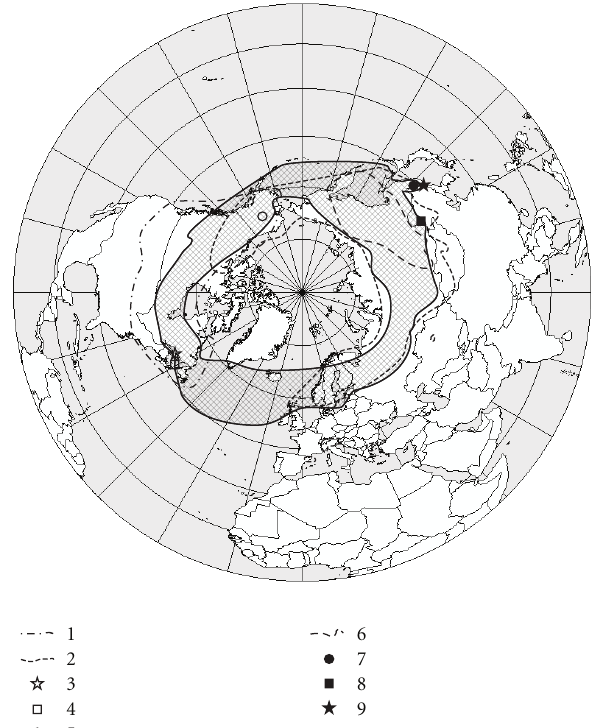
Figure 2: Distribution of the Melanoplini grasshoppers: Melanoplus borealis (1), M. firgidus (2), M. gaspesiensis (3), M. madeleineae (4), M. gordonae (5), Prumna polaris (6), P. specialis and P. montana (7), P. arctica (8), and P. kurentzovi (9) relative to the boreal